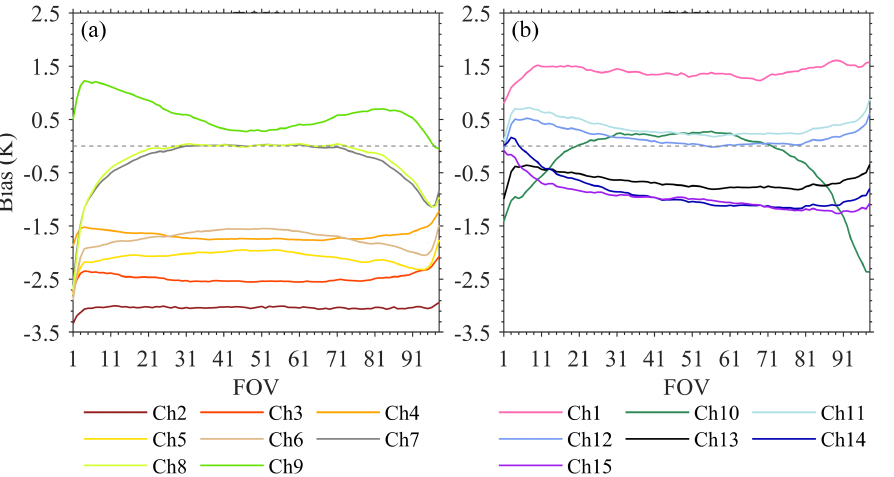
Figure 13. Observation biases (unit: K) varying with the FOVs for ( a ) the 118-GHz channels and ( b ) the other channels after removing the along-scan noises.